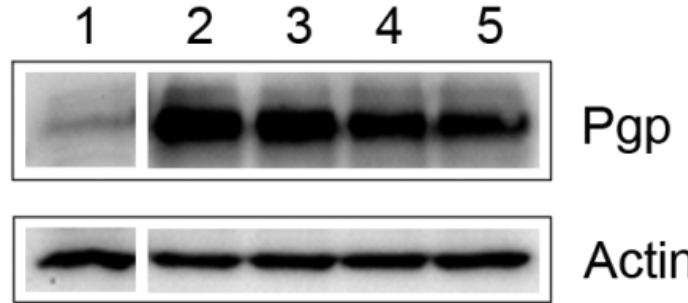
Figure 3. Western blotting analysis of P-gp expression after treatment with Q12 in RDB line. C219 detected 170kDa band in RDB line (lanes 2-5), revealing the decrease in P-gp expression level in RDB cell lines incubated with Q12 (lanes 4, 5). P cells (lane 1)